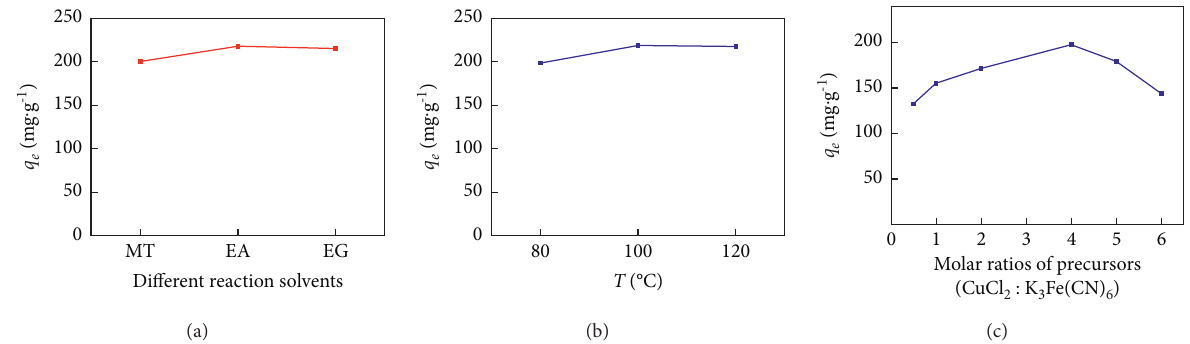
Figure 2: Effects of different reaction conditions on adsorption capacity: (a) solvents, (b) reaction temperatures, and (c) molar ratios of precursor ( c 0 � 110mg/L, m/V � 0.5g/L, T �